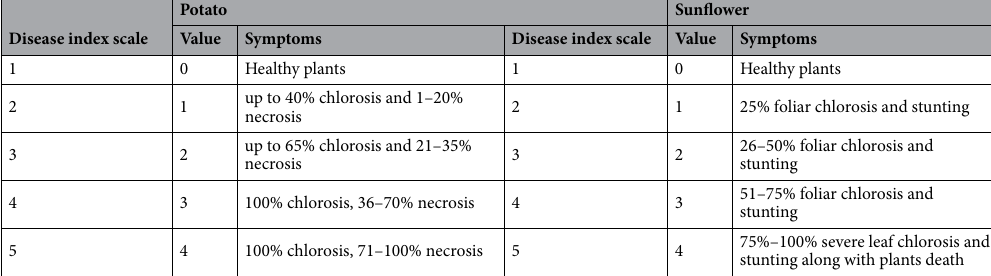
Table 2. Disease severity index of Potato and Sunflower Wilt.